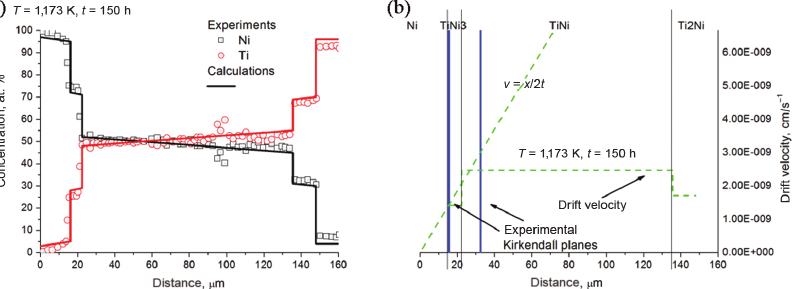
Figure 4: (a) The concentration profile after the diffusional annealing in Ni – Ti diffusion couple after 150 h at 1,173 K. Dots show the experimental results and lines are simulations; (b) vertical lines represent the experimentally determined position of Kirkendall planes, the dotted line denotes the calculated drift velocity.